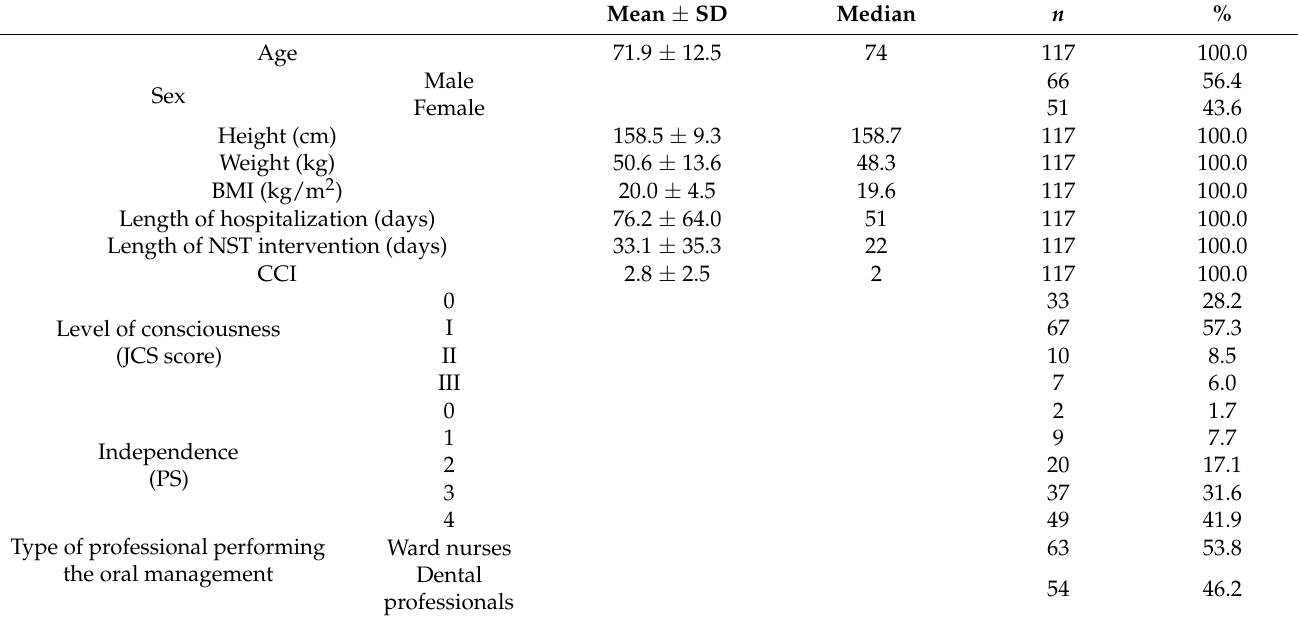
Table 1. Basic demographic characteristics of the study